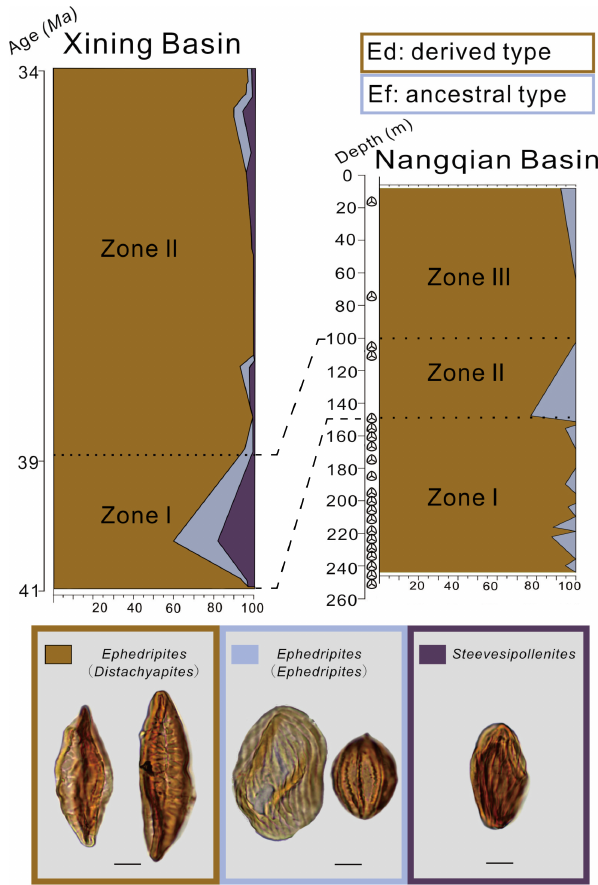
Figure 5. Eocene ephedroid pollen composition in the Xining (north-eastern TP) and Nangqian (east-central TP) basins, illus- trating the distributions of Ephedripites ( Ephedripites ) (ancestral type; “Ef”), Ephedripites ( Distachyapites ) (derived type; “Ed”), and Steevesipollenites . Productive horizons for the Ria Zhong (RZ) sec- tion are indicated by a small trilete spore to the right of the marked depths.